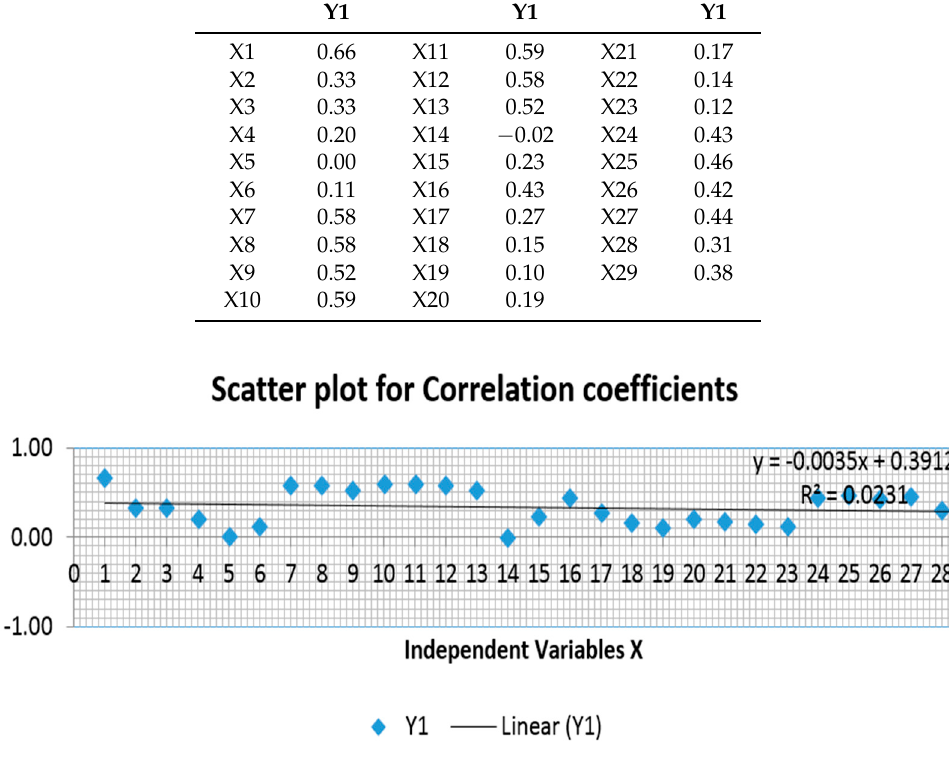
Figure 12. Scatter plot.